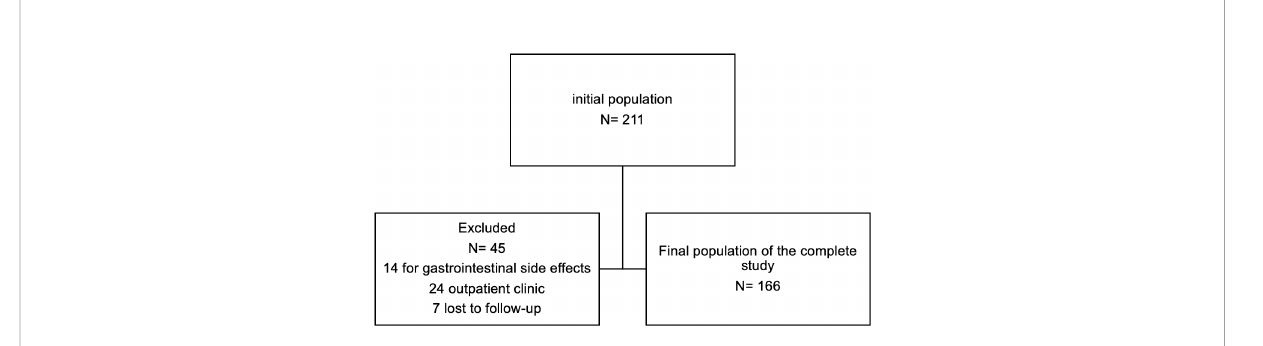
FIGURE 1 Flow chart of the study population. A total of 211 people with T2DM initiated treatment with semaglutide, of whom 166 (78.8%) completed the study on treatment with semaglutide. 45 patients were not suitable for follow-up.